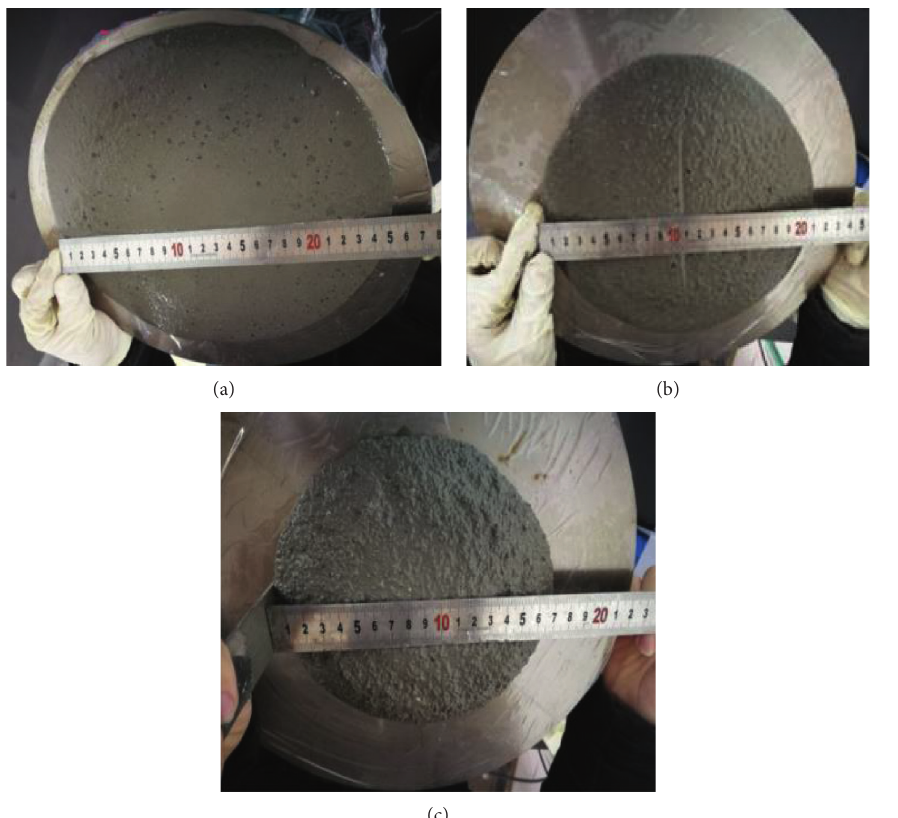
Figure 3: Fluidity test of mortar samples: (a) standard mortar; (b) coral mortar; (c) coral mortar with 15% fly ash and 15%